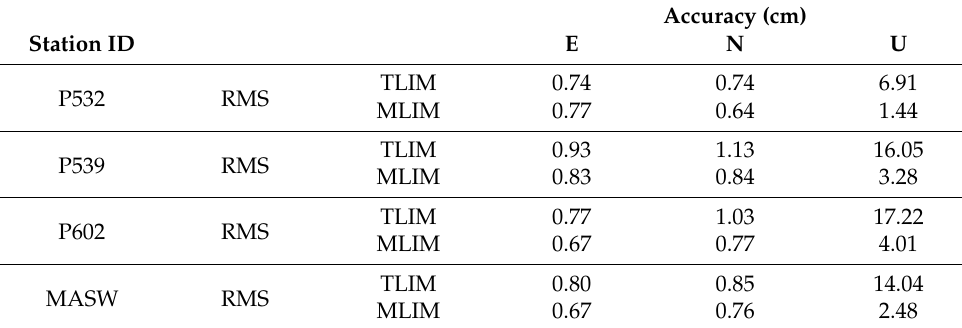
Table 4. Positioning RMS statistical results of each rover station in Dataset